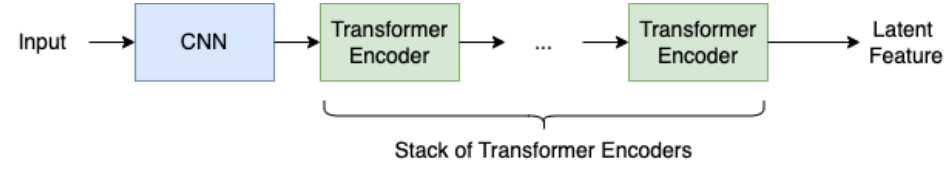
Figure 2. Overall architecture of feature